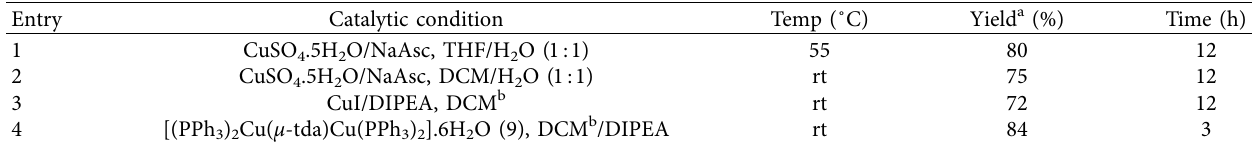
Table 1: Optimization of catalysts for the synthesis of the